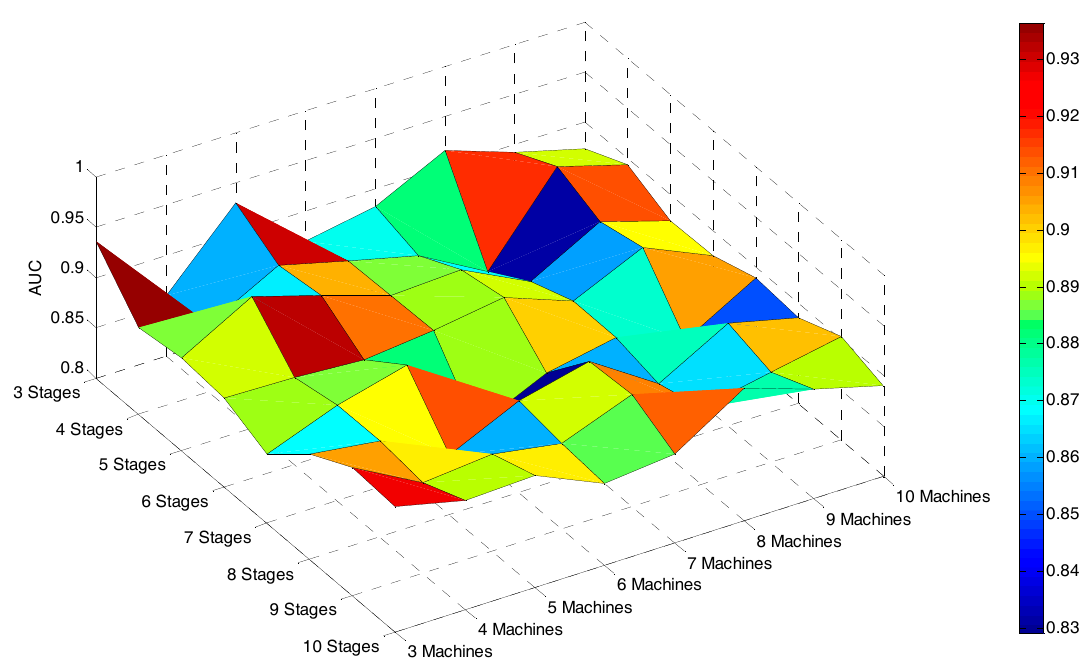
Figure 9. The calculated area under the curves (AUC) for processes with different number of stages and different number of machines per stage .